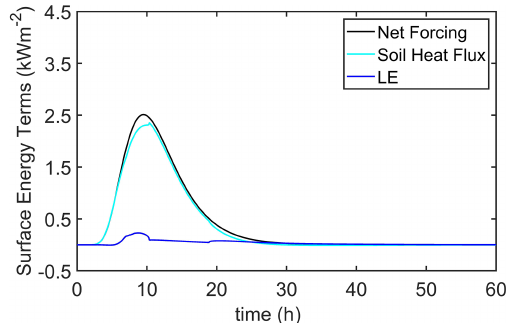
Figure 8. Soil temperatures during the 26 April 2004 MEF burn. Observed data are denoted with symbols, and modeling results (solid lines) are simulated with the full version of the soil surface energy balance (Eq. E 0 + v0